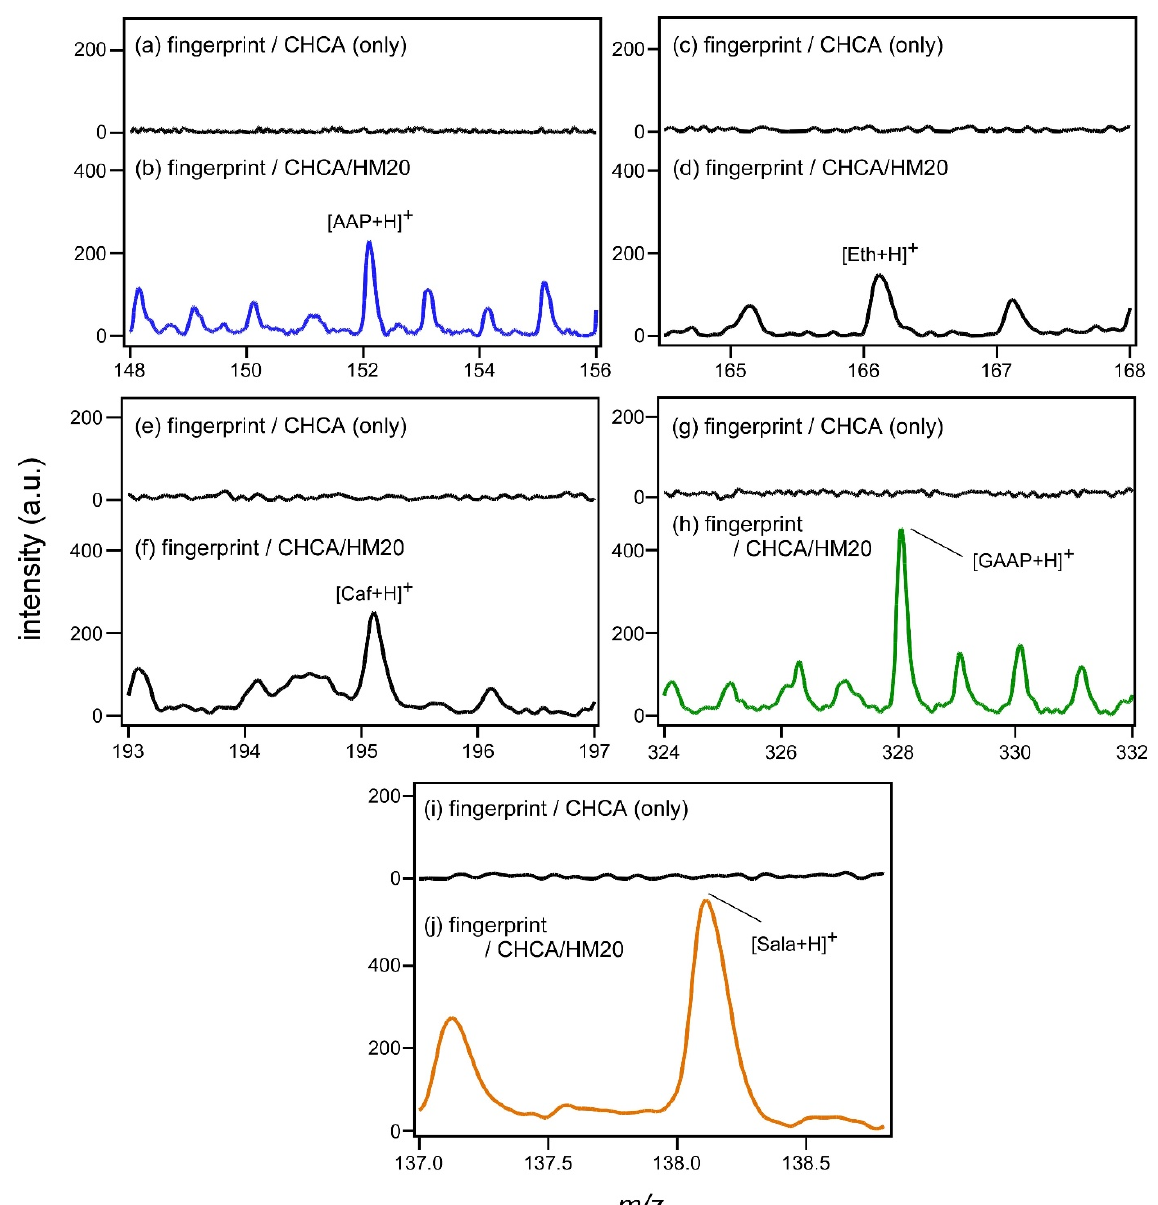
Figure 3. Enlarged view of Figure 2a,b in the mass region related to the ingredients in AAP tablet and AAP metabolite. Table 2. Peaks shown in Figure 3 and the deviations from the accurate mass.